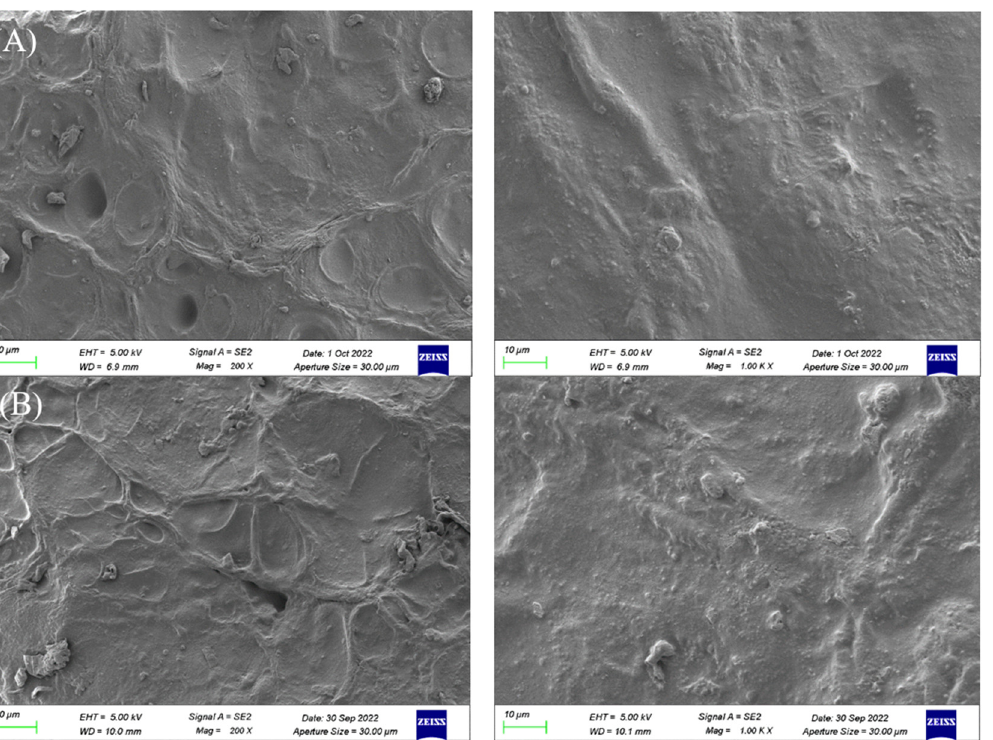
Figure 3. The microscopic morphology of PVP/PVA hydrogel and OF/PVP/PVA hydrogels with the concentration of 100 μg/mL under SEM. ( A ): SEM images of PVP/PVA (left: ×200; right: ×1000). ( B ): SEM images of OF/PVP/PVA hydrogel with a concentration of 100 μg/mL (left: ×200; right: ×1000).